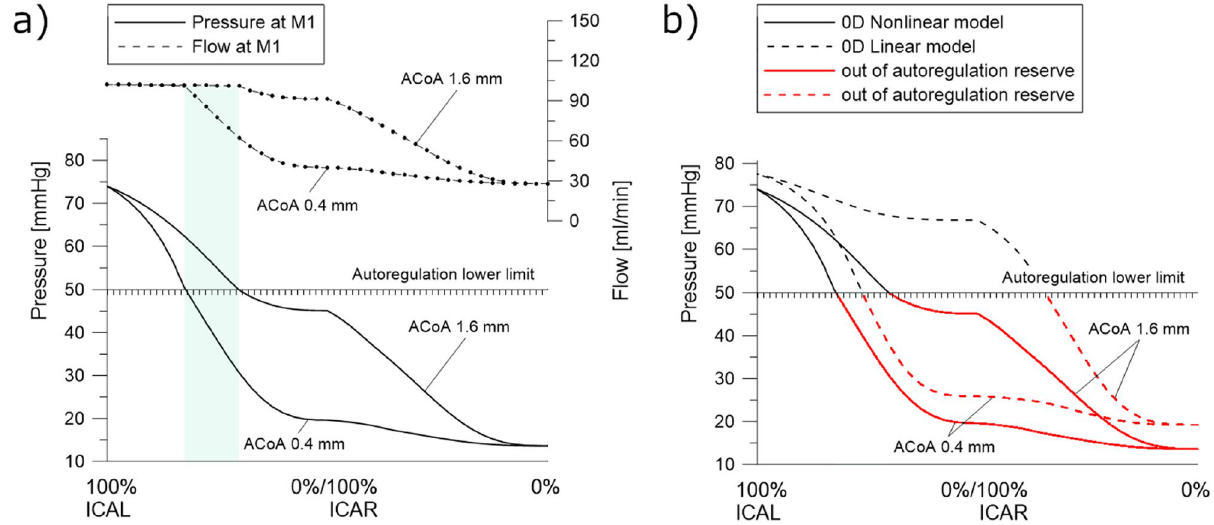
Figure 2. ( a ) Pressure (solid lines) and flow rates (dashed line) in the middle cerebral artery for the gradually increasing occlusion of both ICAs. ( b ) Comparison of autoregulation reserve for nonlinear (solid lines) and linear (dashed lines) models.